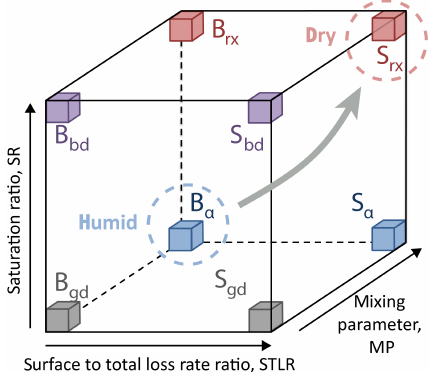
Figure 6. The kinetic cube representing the eight limiting cases for uptake of gases to aerosol particles (Berkemeier et al., 2013). B r x : bulk reaction limited by chemical reaction; B bd : bulk reac- tion limited by bulk diffusion of the volatile reactant and the con- densed reactant; B α : bulk reaction limited by mass accommodation; B gd : bulk reaction limited by gas-phase diffusion; S r x : surface re- action limited by chemical reaction; S bd : surface reaction limited by bulk diffusion of a condensed reactant; S α : surface reaction lim- ited by surface accommodation; S gd : surface reaction limited by gas-phase diffusion. For copper-doped sucrose aerosol particles, the HO 2 uptake coefficient is limited by mass accommodation under humid conditions and by chemical reaction at the surface at low relative